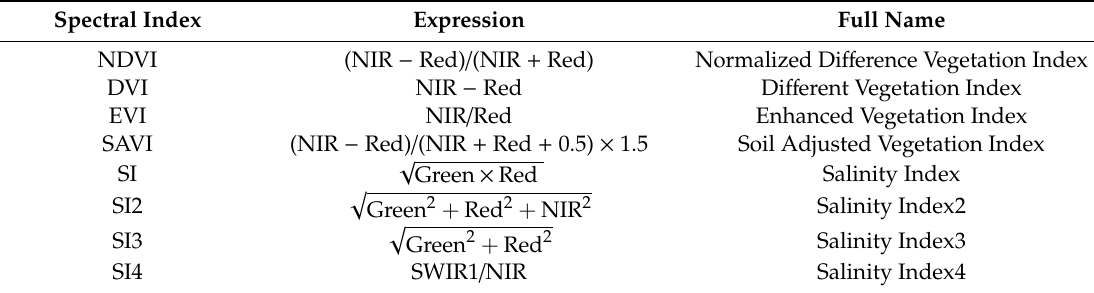
Table 1. The expressions of spectral